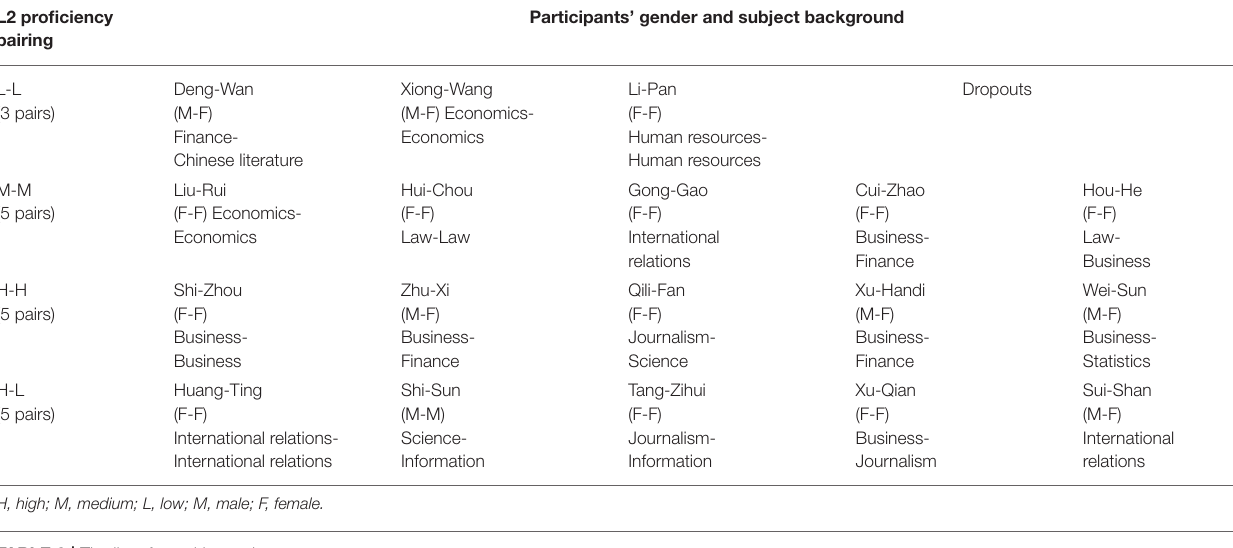
TABLE 1 | Participants’ gender and subject background information in different language proficiency pairings.